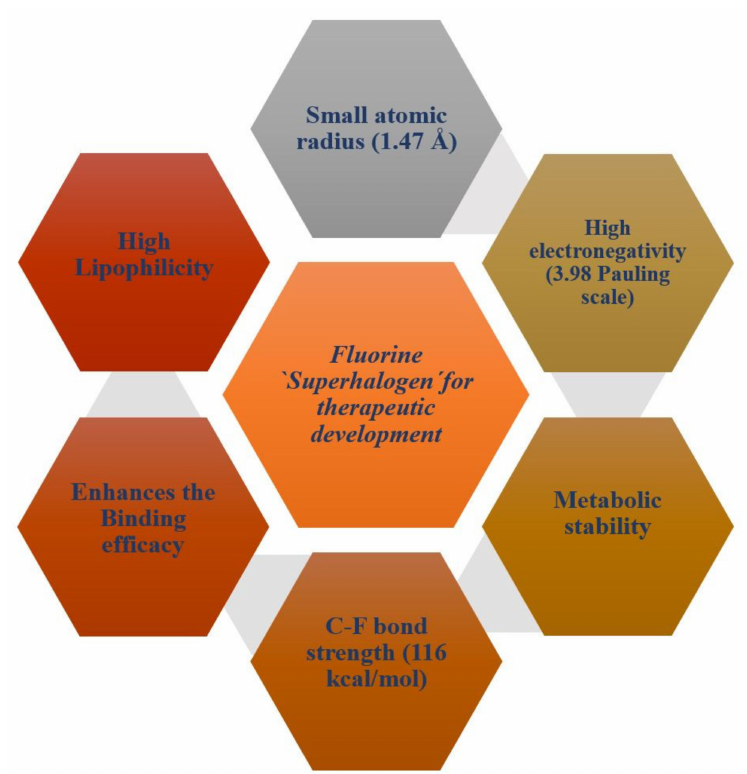
Figure 1. A schematic diagram showing physiochemical and pharmacokinetics properties of fluorine for therapeutic drugs